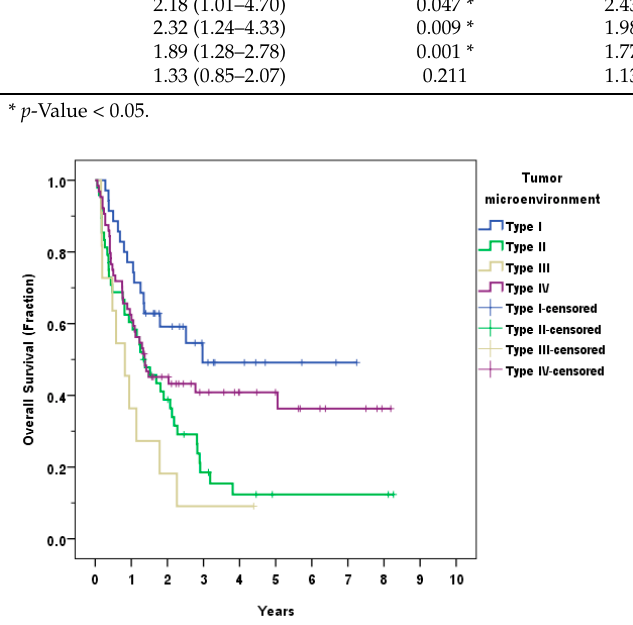
Figure 5. Overall survival (OS) according to the type of tumor microenvironment Figure 5 . Overall survival ( OS ) according to the type of tumor microenvironment ( TME ).